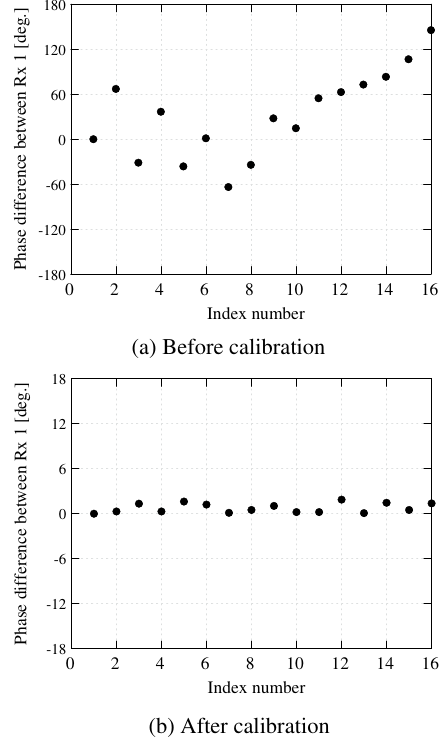
Figure 6. Phase errors of Tx k against Tx#1: ( a ) without, and ( b ) with calibration. -1-0.500.51